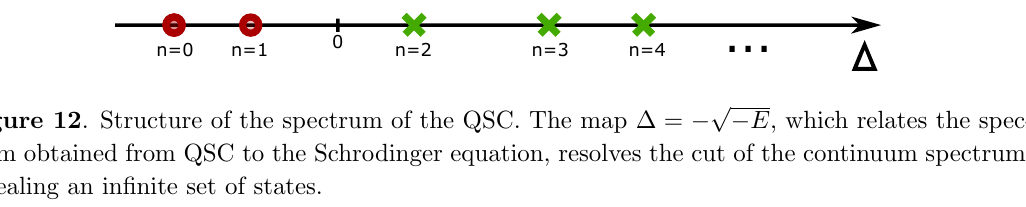
Figure 12 . Structure of the spectrum of the QSC. The map (cid:1) = trum obtained from QSC to the Schrodinger equation, resolves the cut of the continuum spectrum, revealing an in(cid:12)nite set of